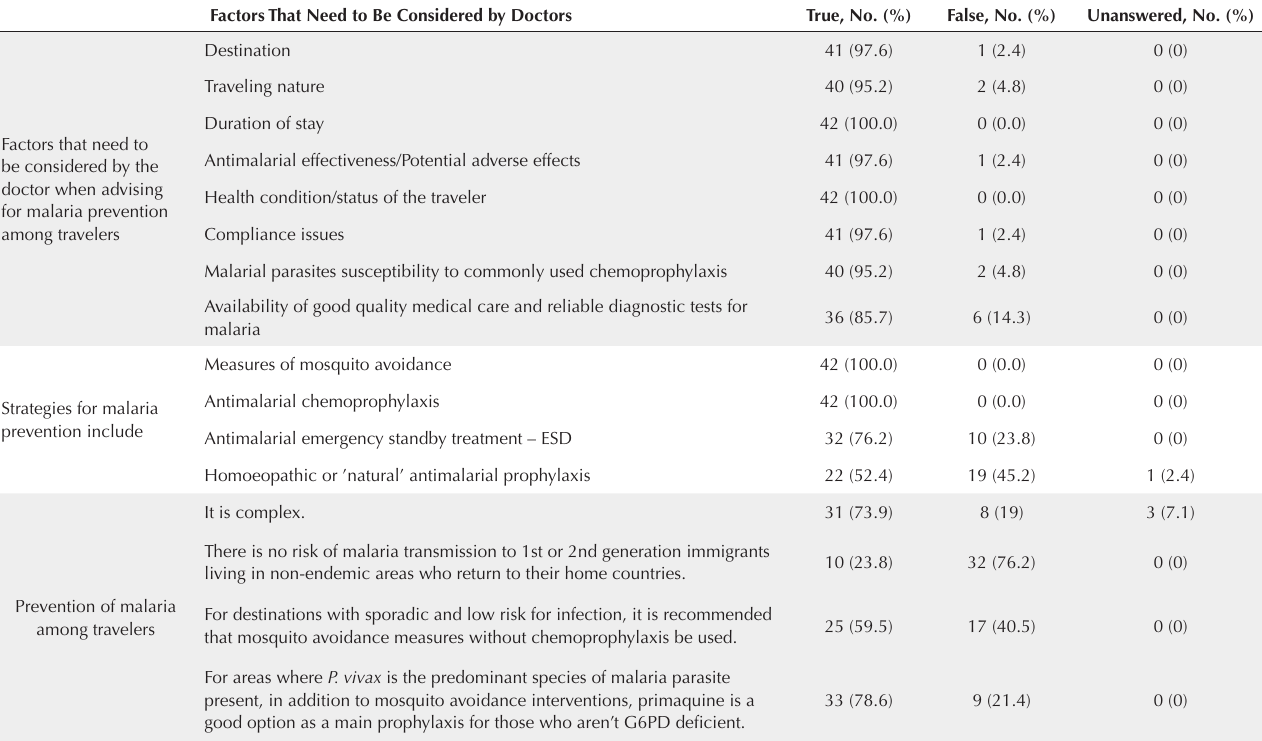
Table 4. Knowledge of the Factors That Need to Be Considered by the Doctors When Advising for the Prevention of Malaria Factors That Need to Be Considered by